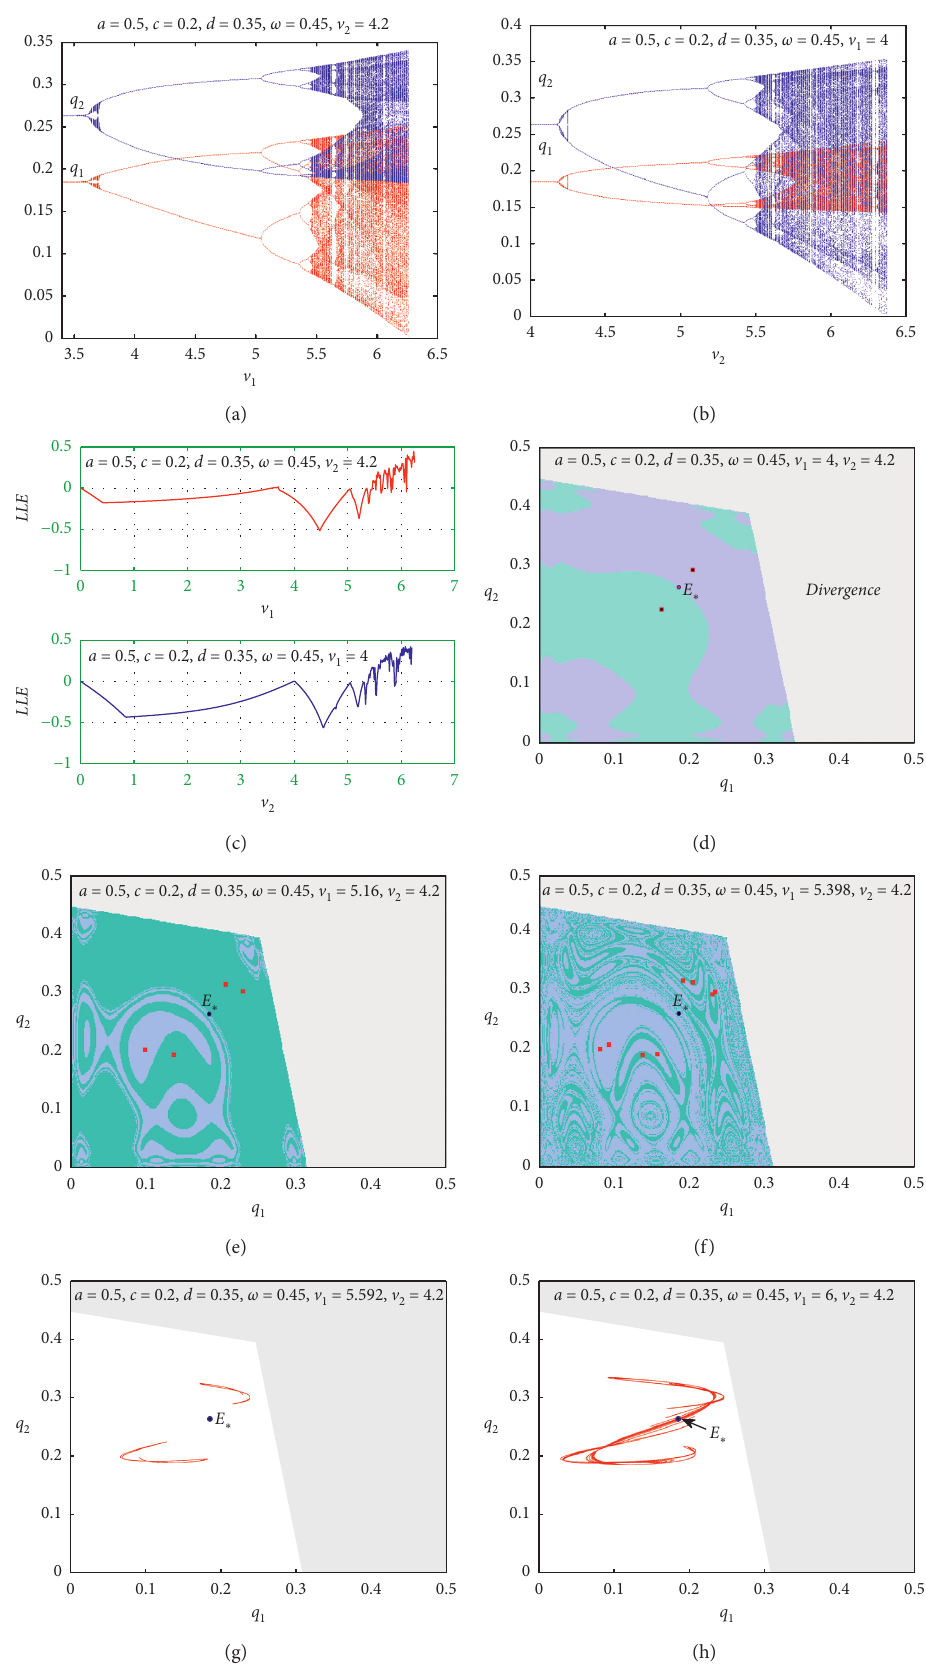
Figure 2: (a),(b) Bifurcation diagram with respect to q ] . Basins of attraction for (d) period-2 cycle at ] 2 � 5 . 398 and ] ] 1 Other parameters are a � 0 . 5 ,c � 0 . 2 ,d � 0 . 35, and ω � 0 .